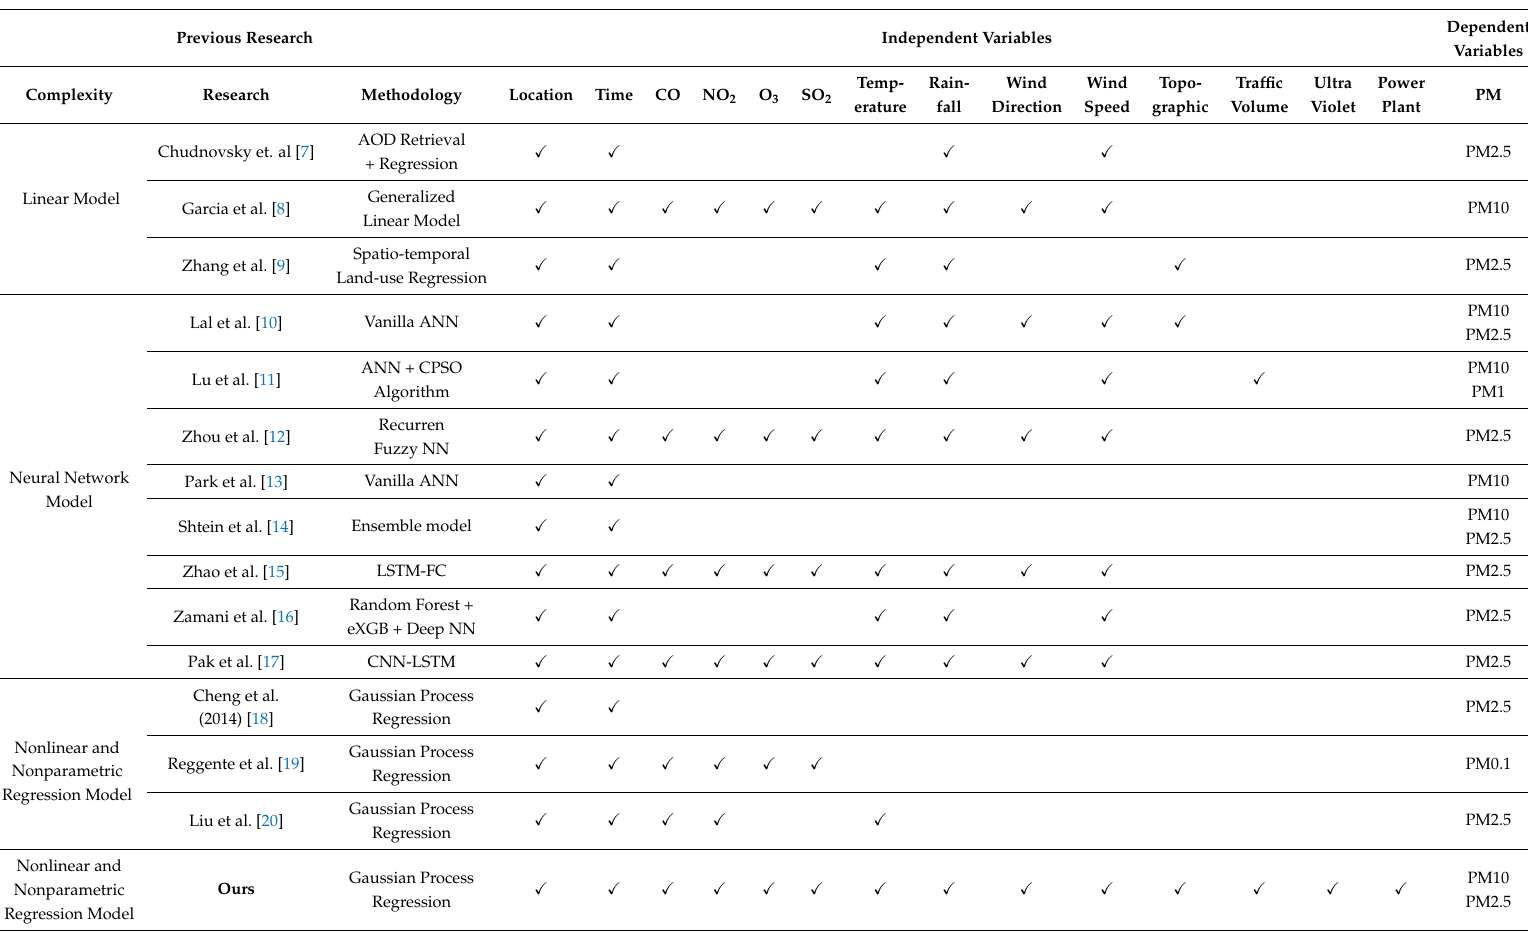
Table 1. Summary of the existing forecasting models of the concentration of particulate matter with respect to complexity, methodology, independent variables, and dependent